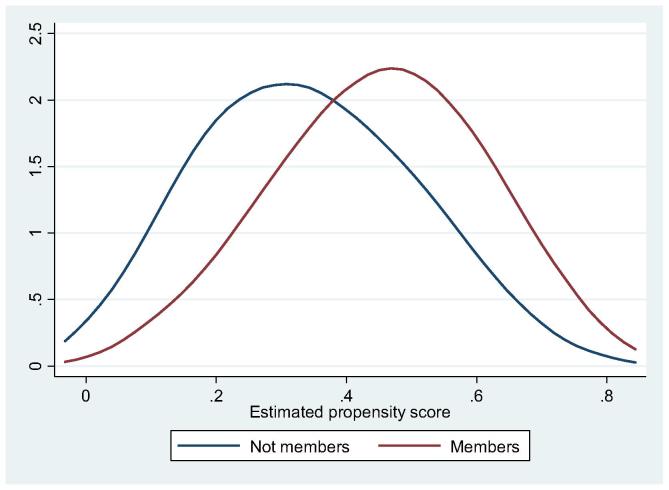
Kernel density of probability of SHG membership.